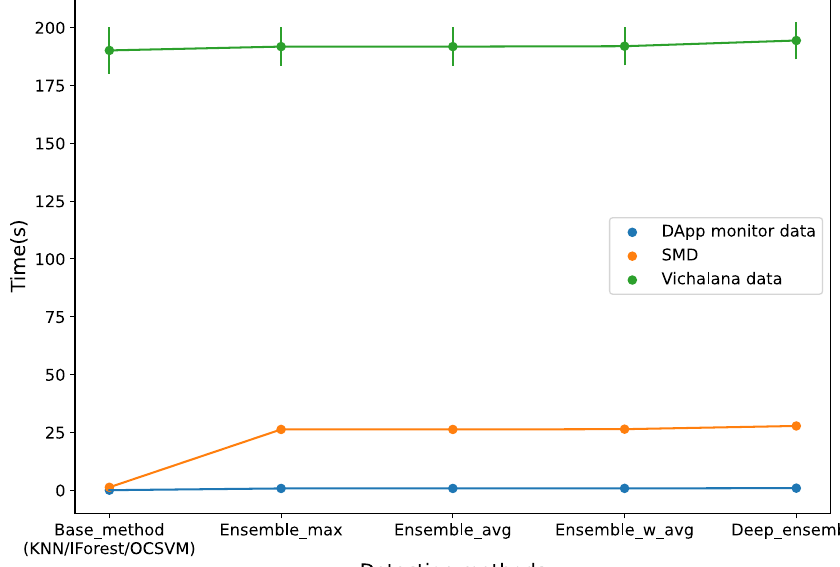
Fig. 5 Time spent of methods in ELBD framework for three datasets